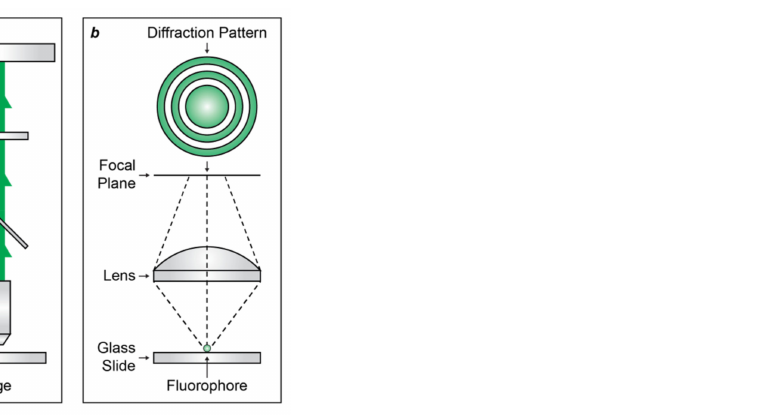
Figure 1. Schematic representations of the main optical components of a conventional fluorescence microscope ( a ) as well as of the Airy pattern ( b ) that the fluorescence of a single fluorophore produces on the focal plane of the objective